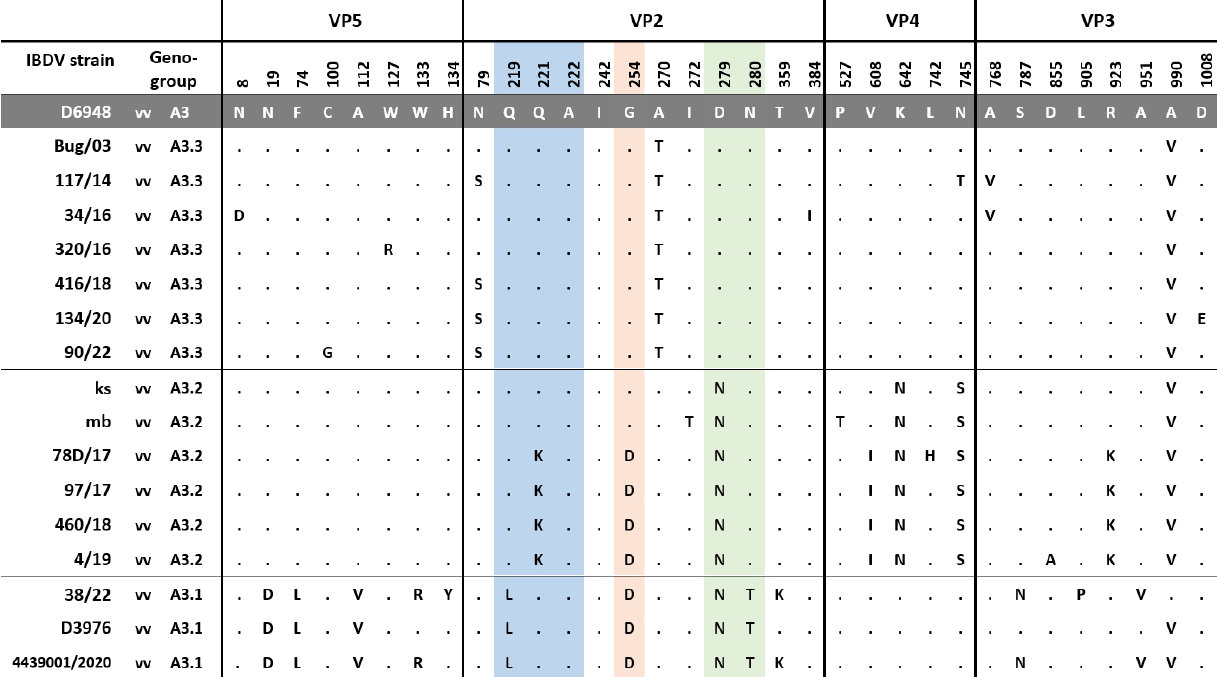
Figure 5. Comparison of amino acid substitutions in viral proteins encoded by segment B between Polish and reference strains. Dots show identity with D6948, while dashes indicate the lack of available aa sequence. Abbreviations: vv—very virulent, trans—transitional IBDV, cv—classical virulent, A—alanine, D—aspartic acid, E—glutamic acid, F—phenylalanine, G—glycine, H- histidine, I—isoleucine, K—lysine, L-leucine, N—asparagine, S—serine, R—arginine, T— threonine, V—valine, W—tryptophan.